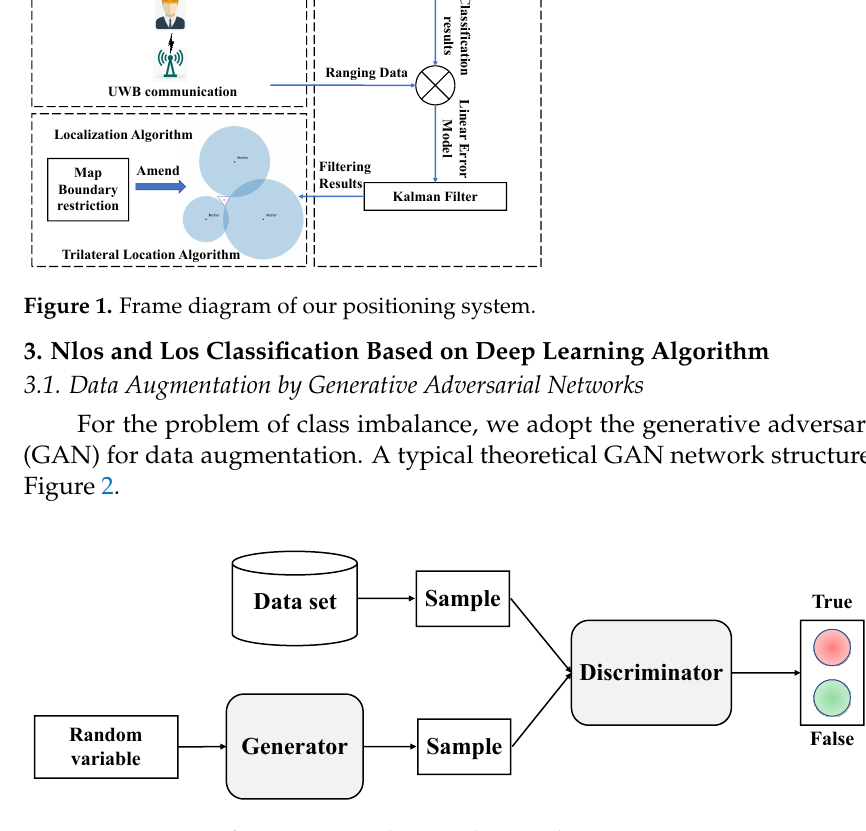
Figure 2. Structure of a generative adversarial